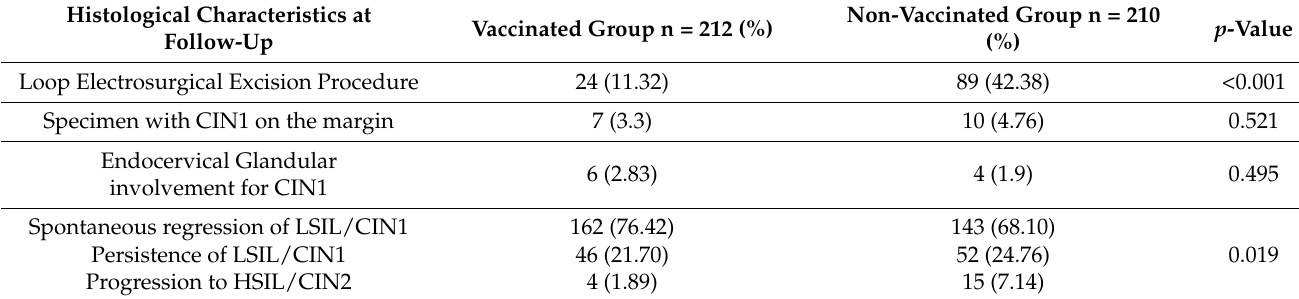
Table 3. Histological characteristics during